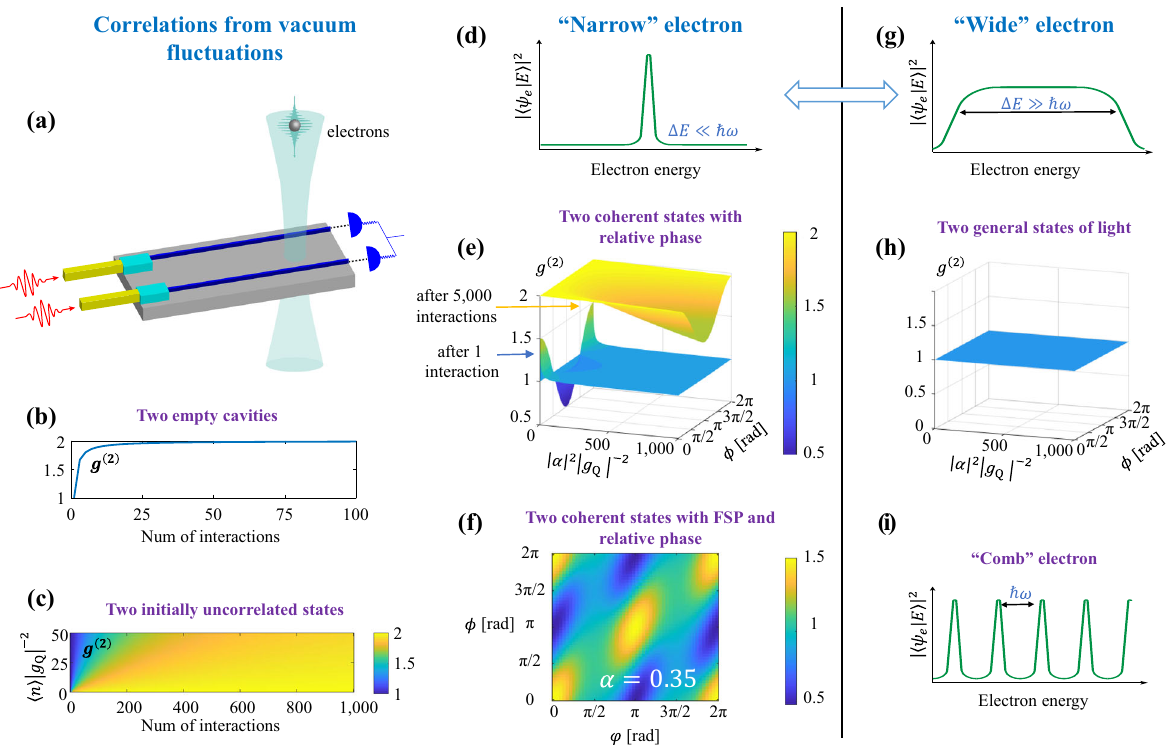
Fig. 5 Controlling the second-order coherence of light via electron shaping. a An analog of the Hanbury Brown and Twiss (HBT) experiment, into which we add photon correlations through the interaction with free electrons. A scheme that can be implemented in current electron microscopes: two separated light pulses interact with consecutive (unshaped) electrons. g (2) for the light created in two initially empty cavities after electron interactions as a function of the number of electrons ( b ), showing that second-order correlations can be induced when starting from vacuum fl uctuations. Map of g (2) for any two initially uncorrelated states of light ( c ). The result is independent of the speci fi c states of light, only depending on the number of electrons and the average photon number (through the parameter 〈 n 〉 | g Q | − 2 ). For many electrons, g (2) → 2, the light becomes bunched, thermalized, and second-order correlations are induced. The comparison of electrons with narrow energy uncertainty ( d ) and wide energy uncertainty ( g ) shows that for a coherent uncertainty wider than the photon energy ℏ ω , interaction cannot induce quantum correlations. The lack of correlations is seen in g (2) in h . It is possible to imitate the effect of a wide- uncertainty electron by instead creating a “ comb ” electron (i) 45,59 . The second-order correlation g (2) can be modi fi ed by consecutive interactions as shown in e , starting by two classical coherent states of light, and plotting g (2) after N = 1 and N = 5000 interactions. For large N , g (2) → 2, the light becomes bunched and thermalized. For a smaller number of interactions, it is possible to achieve g (2) < 1, an anti-bunched light, depending on the relative phase ϕ between the two states of light. α is the coherent state parameter and g Q is the coupling strength. A map of g (2) after one interaction is shown in f , demonstrating the role of the relative phase of light ϕ and the phase φ accumulated by the free- space propagation (FSP) of the electron between the two points of interaction. The interaction strength is g Q =